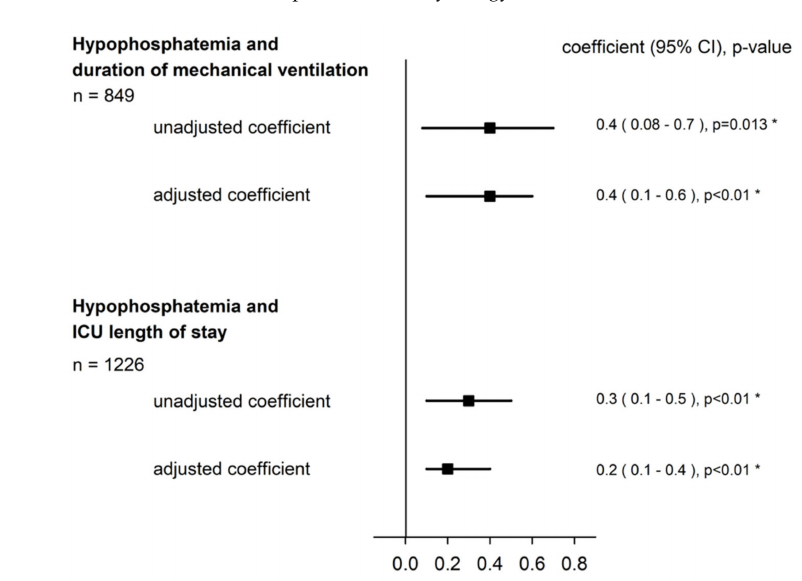
Figure 2. Hypophosphatemia, duration of mechanical ventilation, and ICU LOS in all ICU patients. Regression coefficient (95% confidence interval) on a logarithmic scale. When the log-transformed coefficient was back-transformed (i.e., exponentiated), hypoP at ICU admission multiplied the duration of mechanical ventilation by 1.5 days (CI 95%: 1.1–1.8) and the ICU LOS by 1.2 days (CI 95%: 1.1–1.5). Adjusted coefficient was adjusted to: gender, SAPSII on ICU admission, infection within